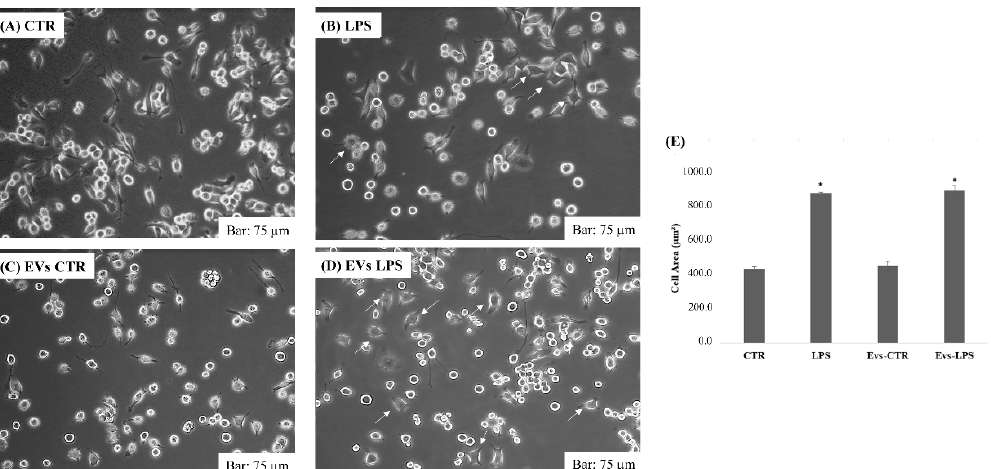
Figure 2. Morphology analysis of BV2 cells cultured in 6-plates in absence of treatment ( A ) or after treatment with LPS (1 ug/mL) ( B ), EVs-CTR (10 μ g/mL) ( C ), and EVs-LPS (10 μ g/mL) ( D ). Bar 75 μ m. ( E ) Cell areas were quantified using Image J software in calibrated unit ( μ m 2 ). * p < 0.05 compared with CTR. Data are expressed as means ± SD of three independent experiments.